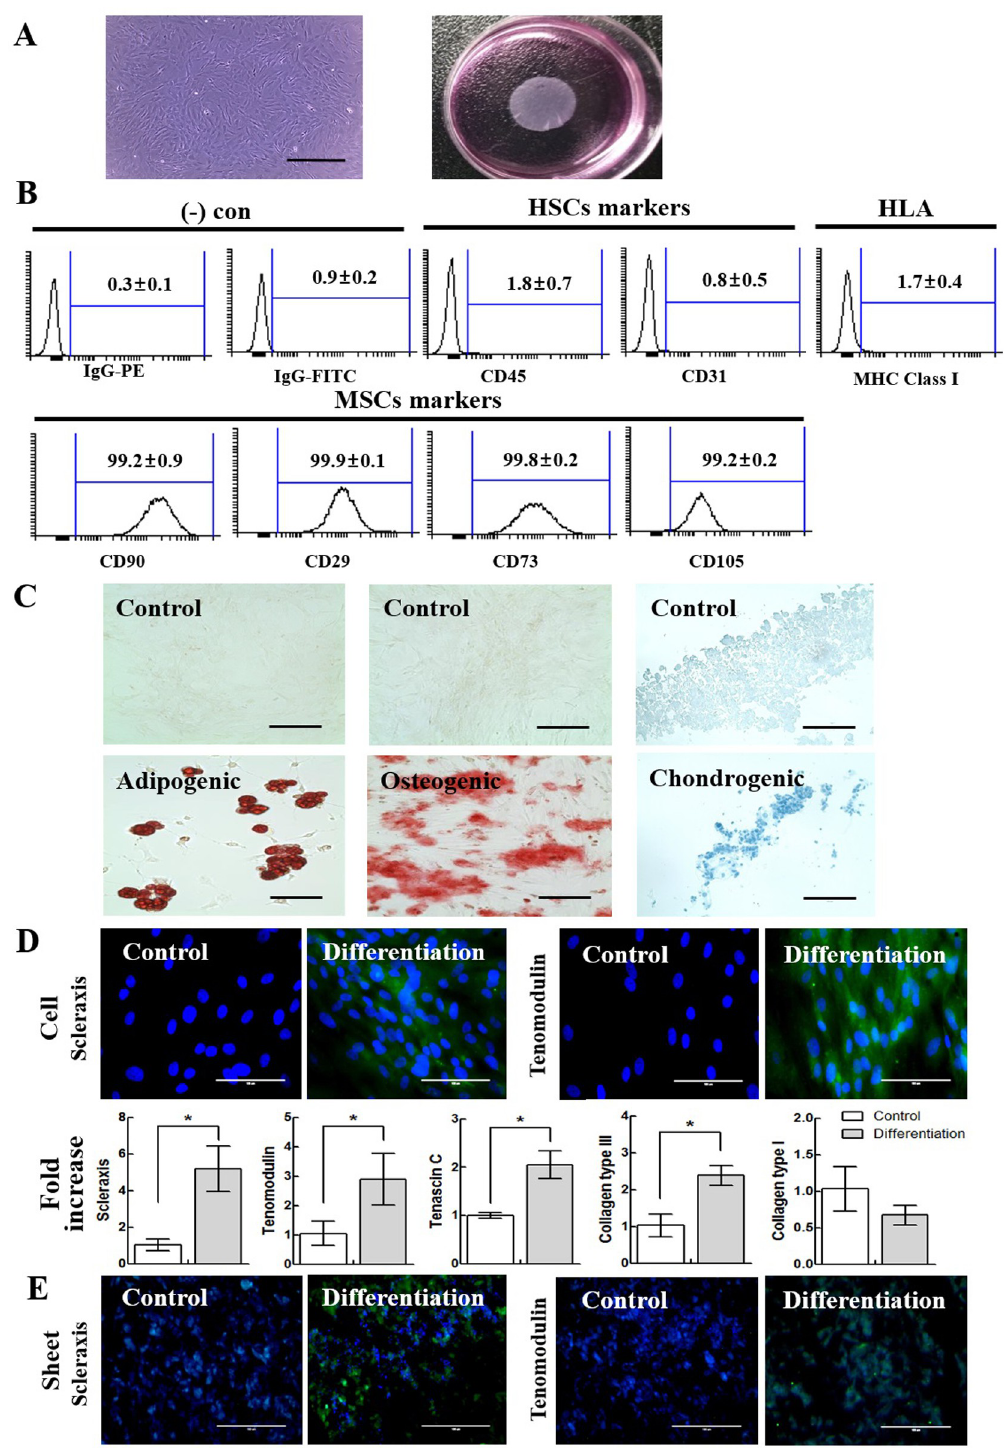
Fig 3. Characterization of rat adipose-derived stem cells (ASCs). (A) The morphology of the cell sheet with plastic adhesion (left) and the shape of the shrunken cell sheet (right). The size bar represents 400 μ m (magnification 10X). (B) The expression of MSC markers in rat ASCs (n = 3). (C) The adipogenic, osteogenic, and chondrogenic differentiation potential of rat ASCs (n = 3). The differentiation sites are shown in red or blue. All size bars represent 100 μ m (magnification 40X). (D) The tenogenic differentiation potential of rat ASCs with 100 ng/ml GDF-7 treatment for two weeks. The side that has not